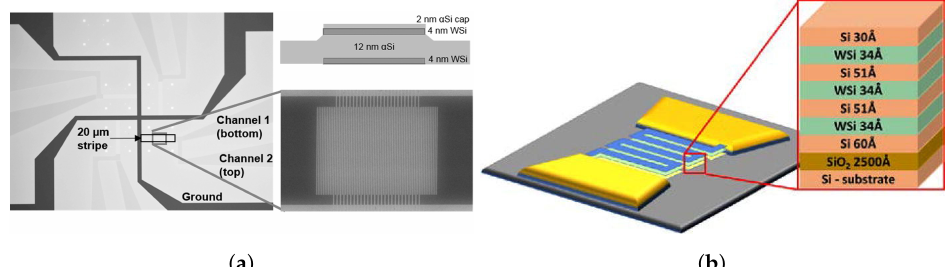
Figure 3. ( a ) A two SNSPD-layer device with optical image (left) of the whole structure and a schematic cross-sectional view in top-right and a SEM image of the SNSPD itself (bottom-right). Figure reproduced from Verma, et al., Appl. Phys. Lett. 108 , 131108 (2016) [114]. ( b ) Schematic of representation of a three SNSPD-layer device. Figure reproduced from Florya, et al., Low Temperature Physics 44 , 221–225 (2018)